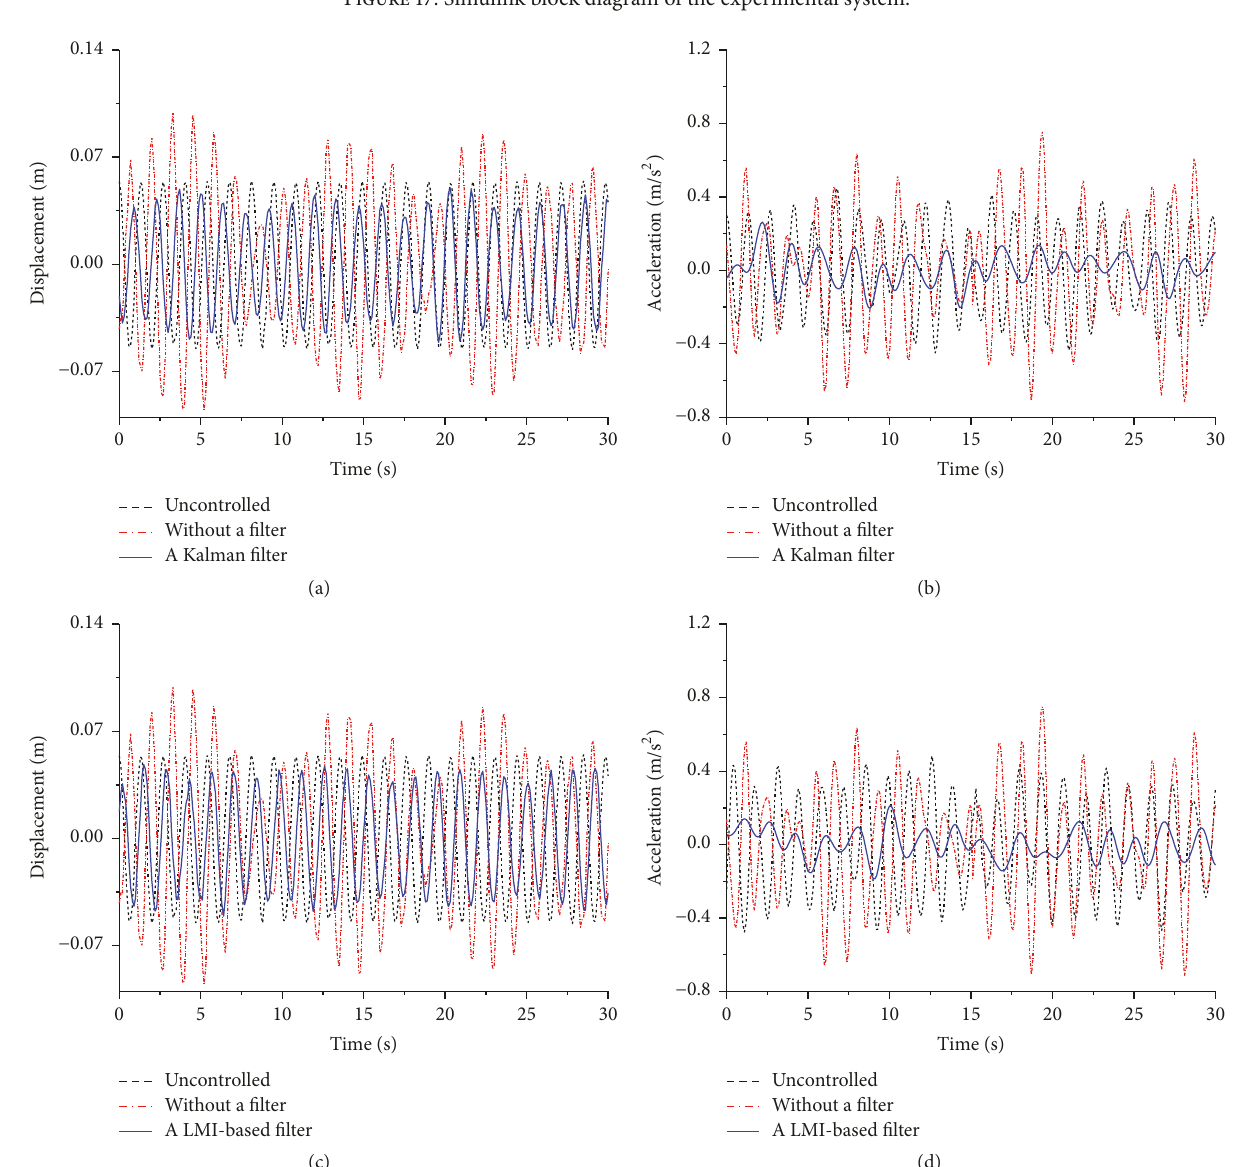
Figure 18: Comparison of structural responses in 4th floor of the experimental system: (a) and (c) displacement; (b) and (d)